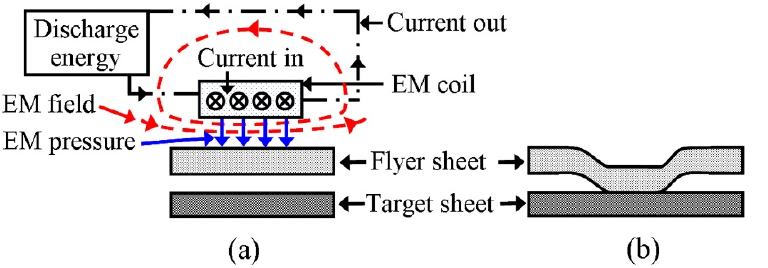
Figure 1. Schematic views of ( a ) MPW arrangement with coil and overlapping sheets, and ( b ) joint configuration.